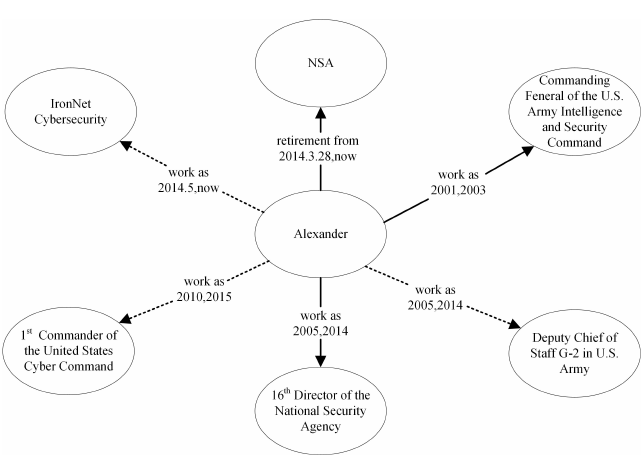
Figure 1. The TKG of Alexander’s career